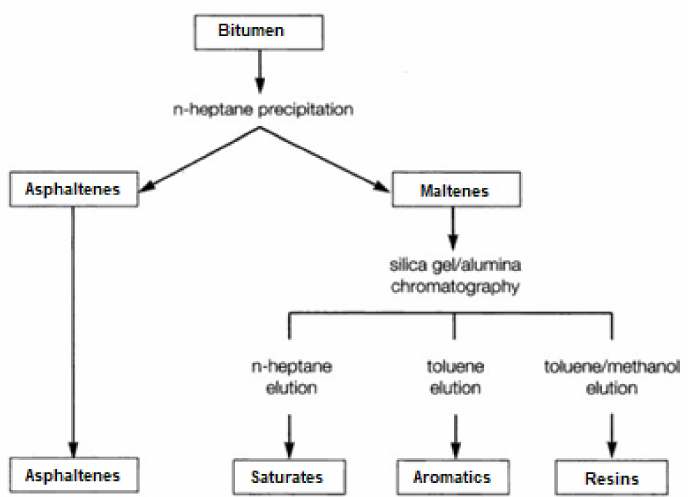
Figure 1. Schematic for the group separation of chemical constituents in